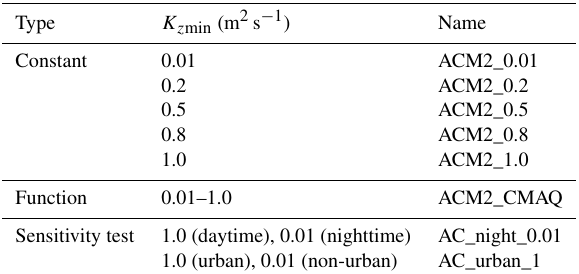
Table 2. Scenarios simulated in the present study with a different setup of K z min in the ACM2